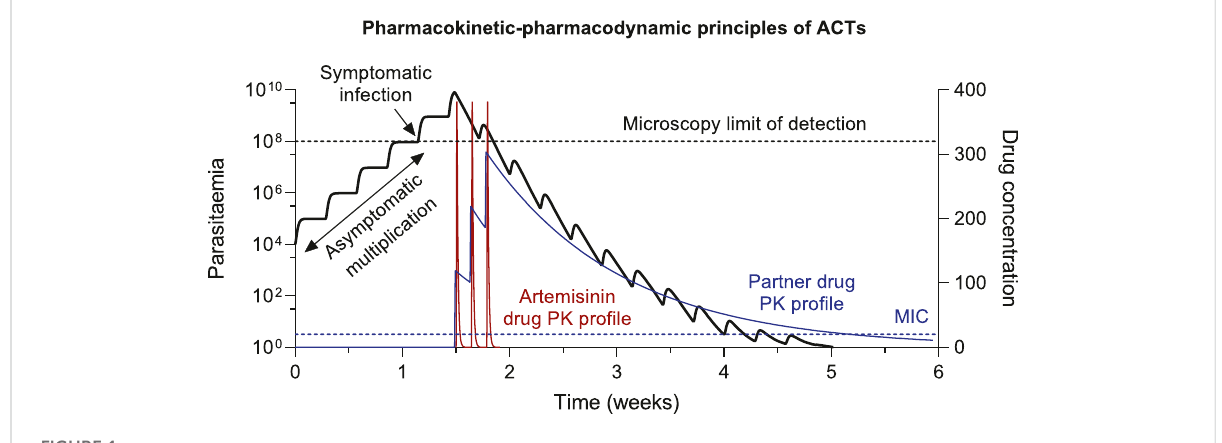
FIGURE 1 Pharmacokinetic-pharmacodynamic (PK-PD) principles of ACT treatment. The minimal inhibitory concentrations (MIC) is the lowest antimalarial drug concentration that will inhibit the visible growth of the parasites, resulting in parasite elimination at drug concentrations > MIC and parasite growth at drug concentrations <